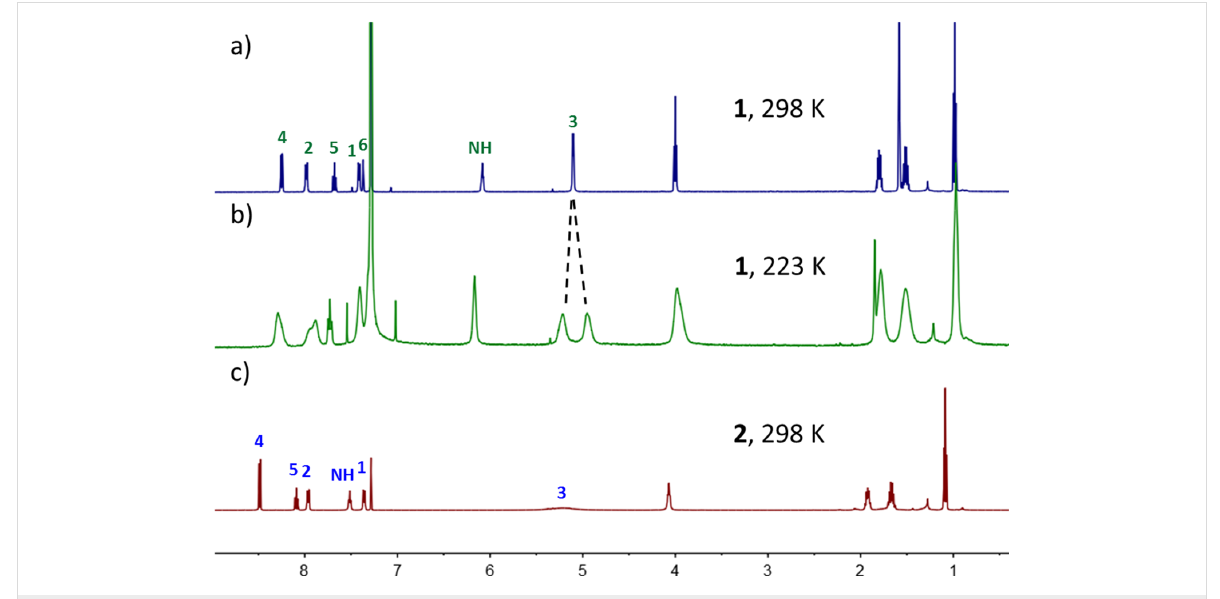
Figure 1: 1 H NMR spectra (500 MHz, CDCl3) of a) 1 at 298 K, b) 1 at 223 K, and c) 2 at 298